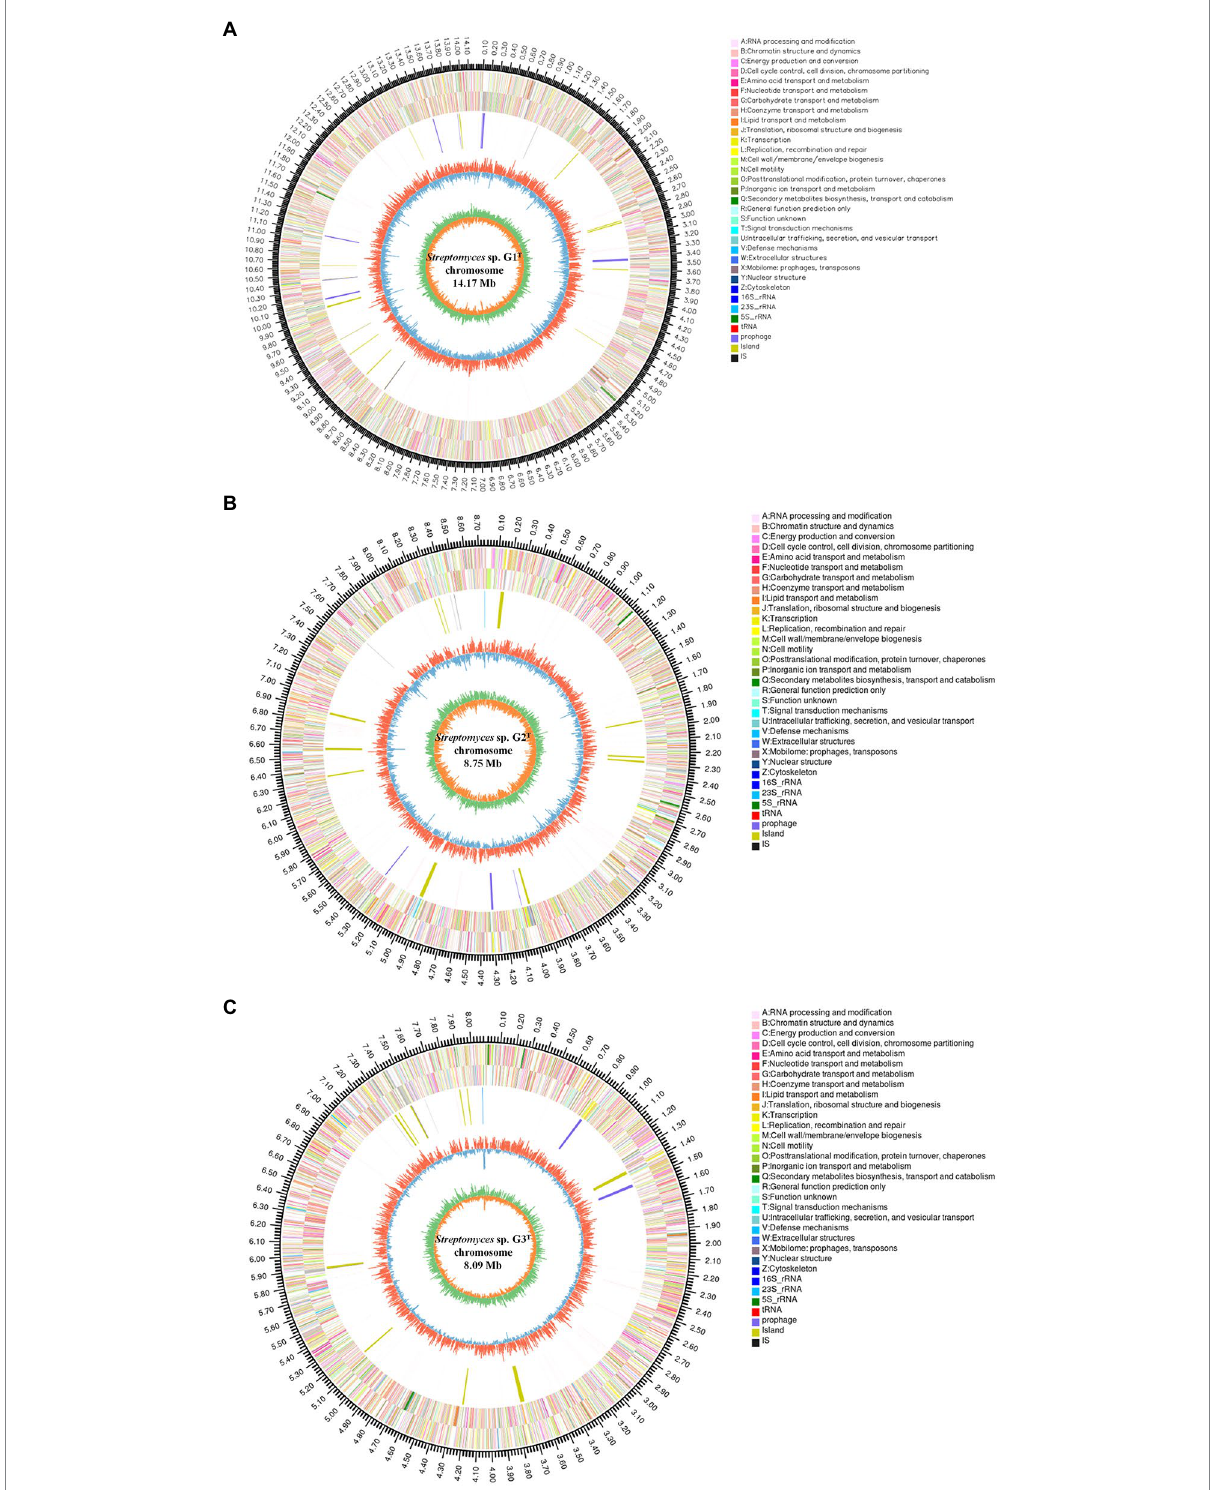
FIGURE 2 Genome map of the chromosome from strains Streptomyces sp. G1 T (A) , Streptomyces sp. G2 T (B) and Streptomyces sp. G3 T (C) . The circles for chromosome from the outside to the center represent the genome size, the CDS on the positive and negative strands with different colors indicating the different COG functional classifications, rRNA and tRNA, GC content, and GC skew,